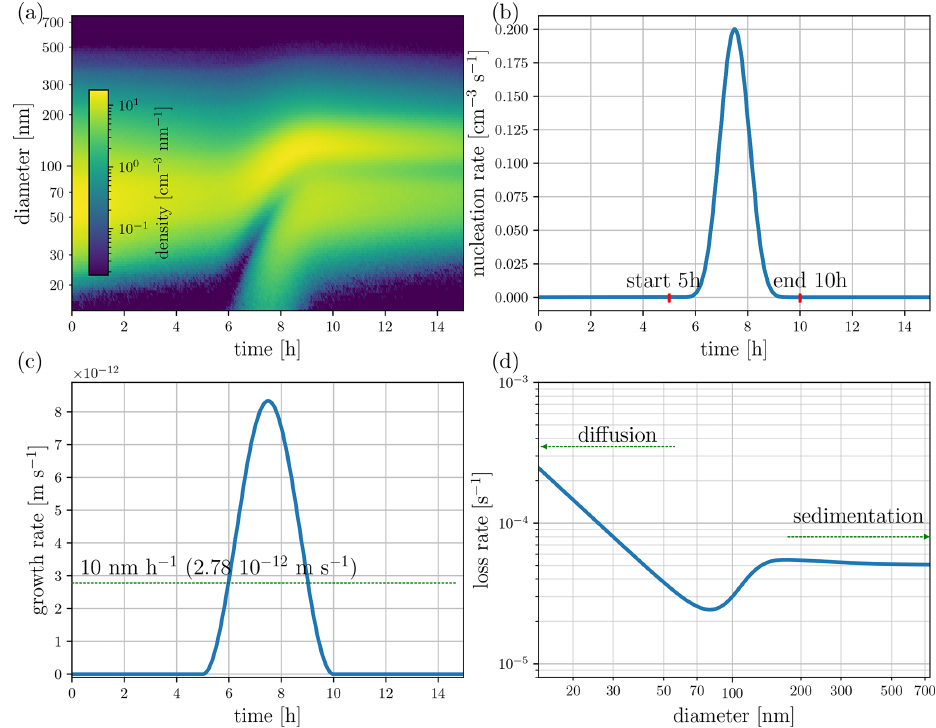
Figure 1. Cases 1 and 2 – a nucleation event, showing true (simulated) processes: (a) particle size density (measurement), (b) nucleation rate, (c) growth rate and (d) loss